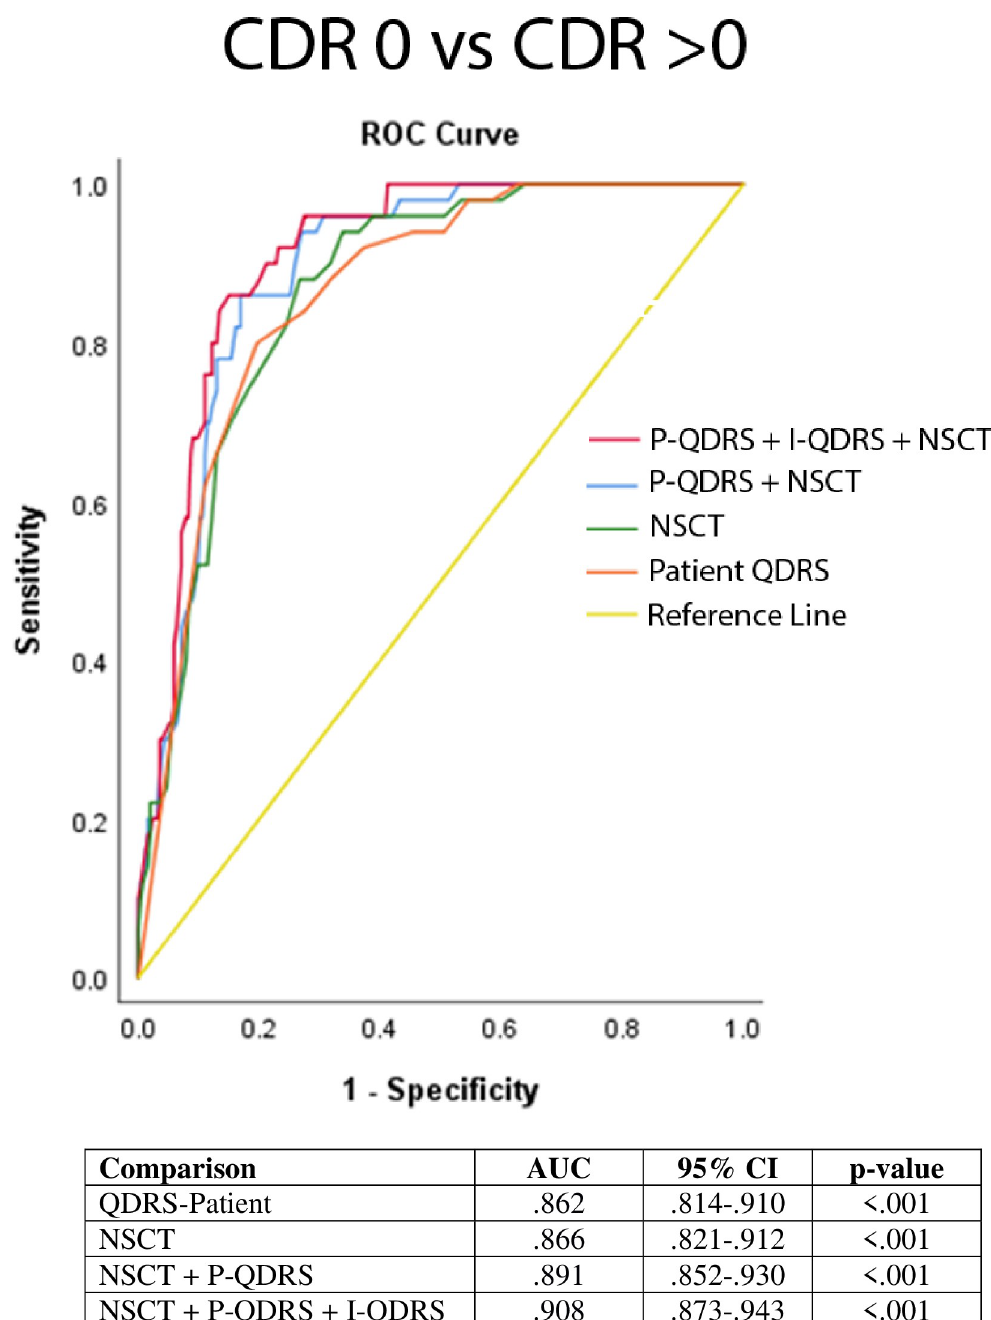
Fig 3. Discrimination of the Number Symbol Coding Task. ROC curves comparing the discriminability of the NSCT, patient and caregiver forms of the QDRS to differentiate healthy controls (CDR 0) from individuals with any form of cognitive impairment (CDR > 0). The combination of the NSCT, a patient-reported outcome (patient QDRS), and informant-reported outcome (caregiver QDRS) correctly classified 90.8% of cases (see details in text). Key: AUC = Area under the curve; QDRS = Quick Dementia Rating System; NSCT = Number Symbol Coding Task. off score of 36 provided the best combination of sensitivity and specificity allowing for the cre- ation of profiles for clinical use. The NSCT correlated with hippocampal and ventricular vol- umes supporting its relationship with neurodegeneration.